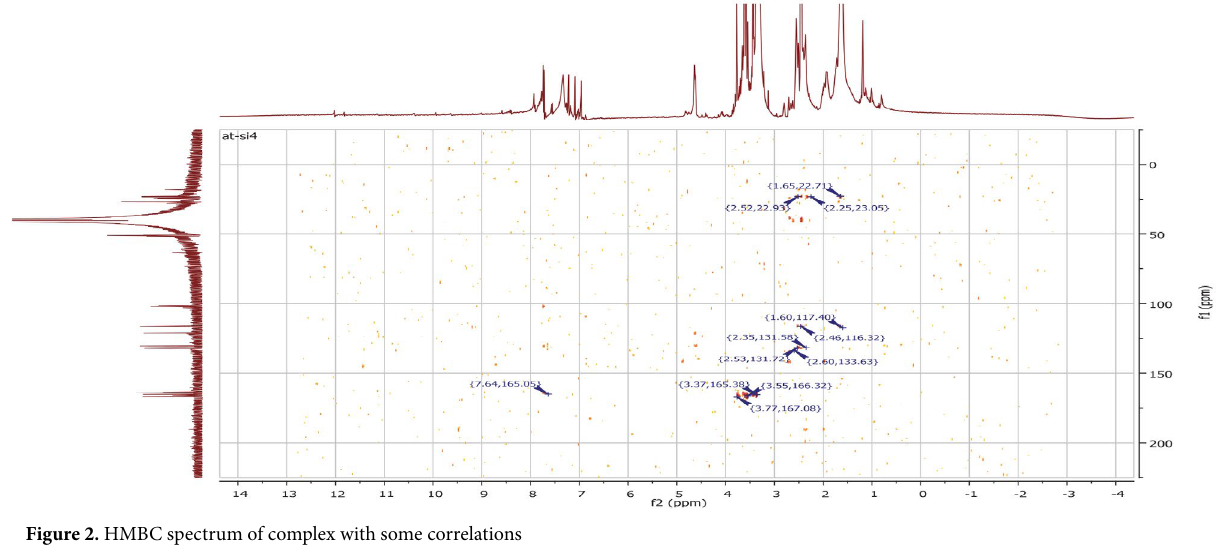
Figure 2. HMBC spectrum of complex with some correlations